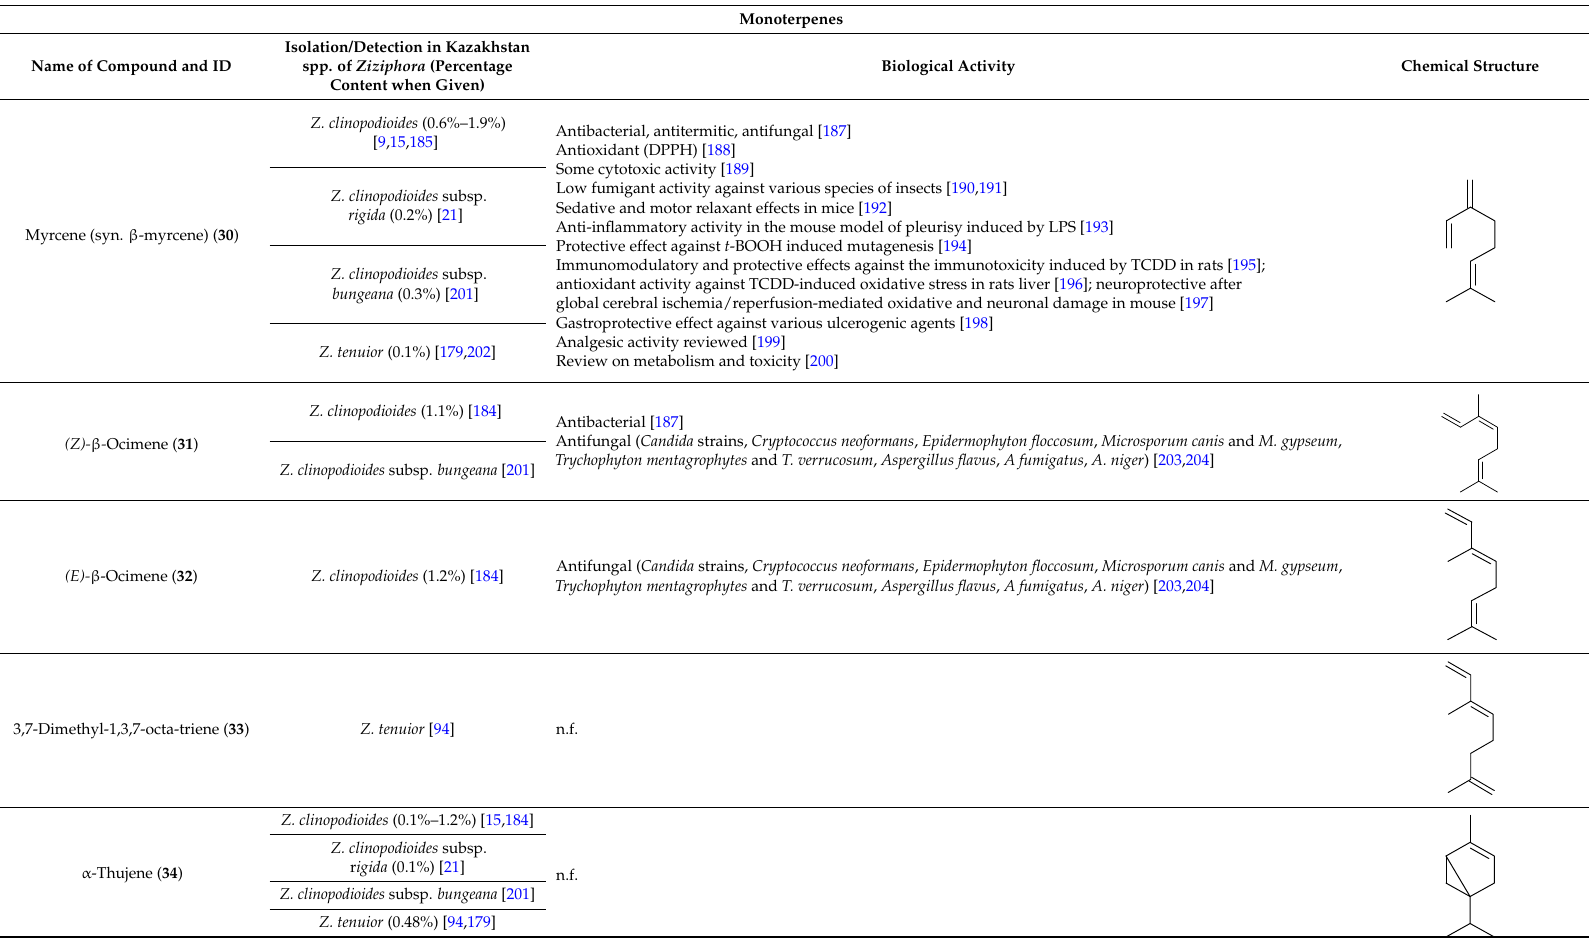
Table 3. Mono and sesquiterpenic substances isolated from Kazakhstan Ziziphora species (N.f.—not found). Monoterpenes